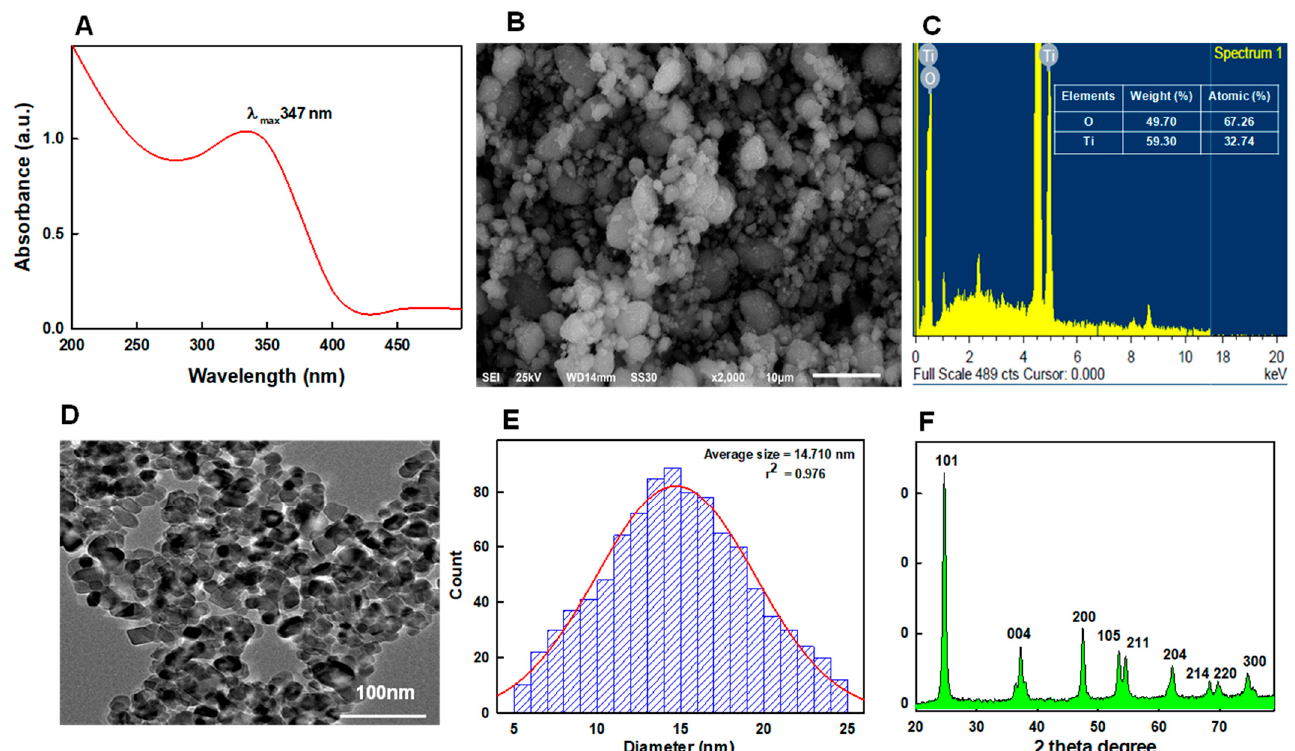
Figure 4. UV-Vis absorption spectrum of TiO 2 NPs showing the characteristic SPR peak at 347 nm ( A ). ( B , C ) show the SEM image and energy dispersive X-ray analysis of TiO 2 NPs, respectively. ( D ) shows a representative TEM micrograph of TiO 2 NPs and ( E ) shows the TiO 2 NP size distribution. ( F ) shows the X-ray diffraction pattern of TiO 2 NPs.